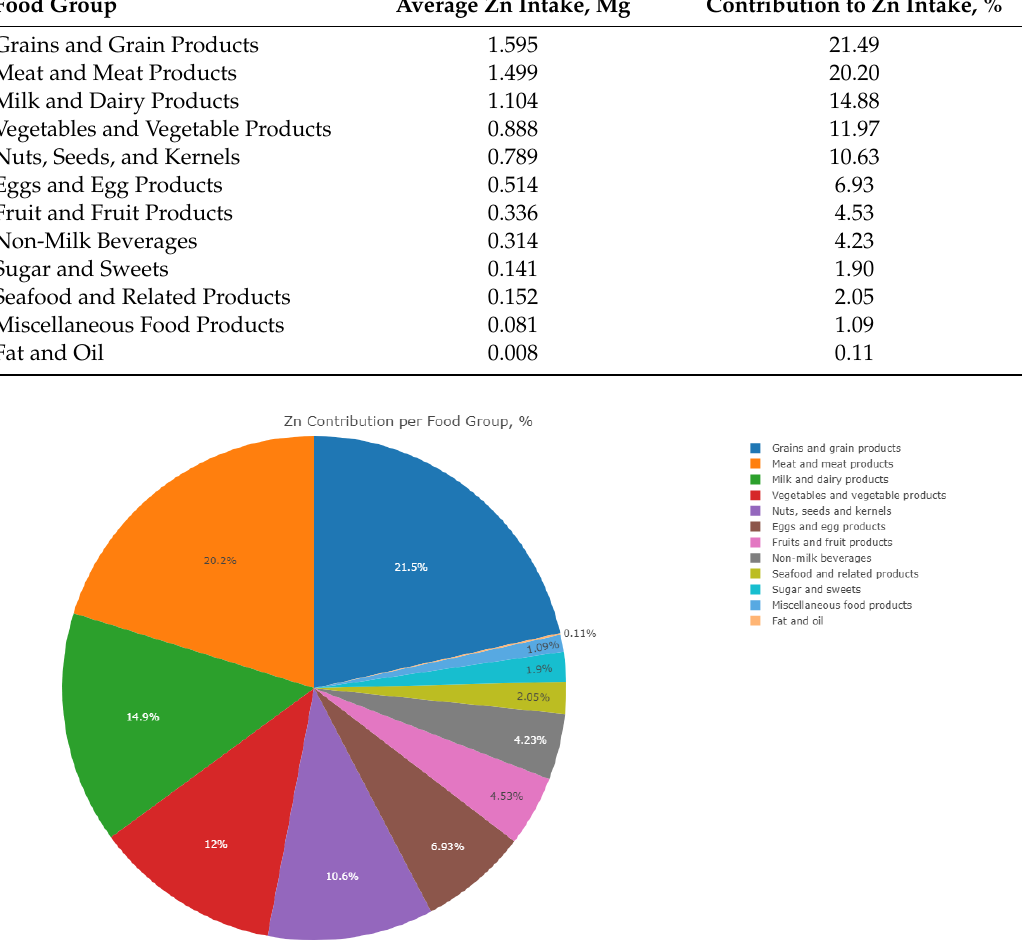
Figure 1. Top ten food sources of Zn in participants’ diets.